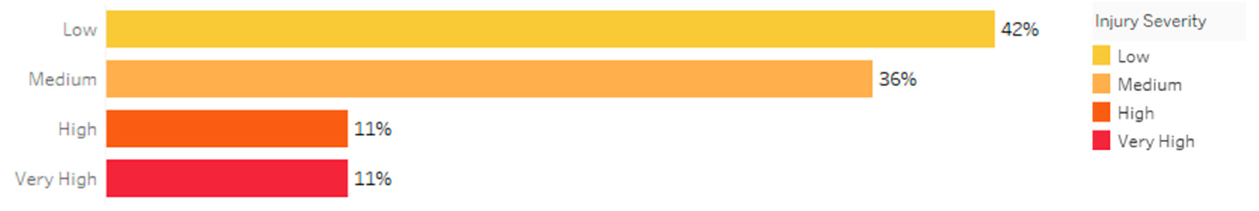
Figure 3. Percentage of injuries by insurance claim severity.